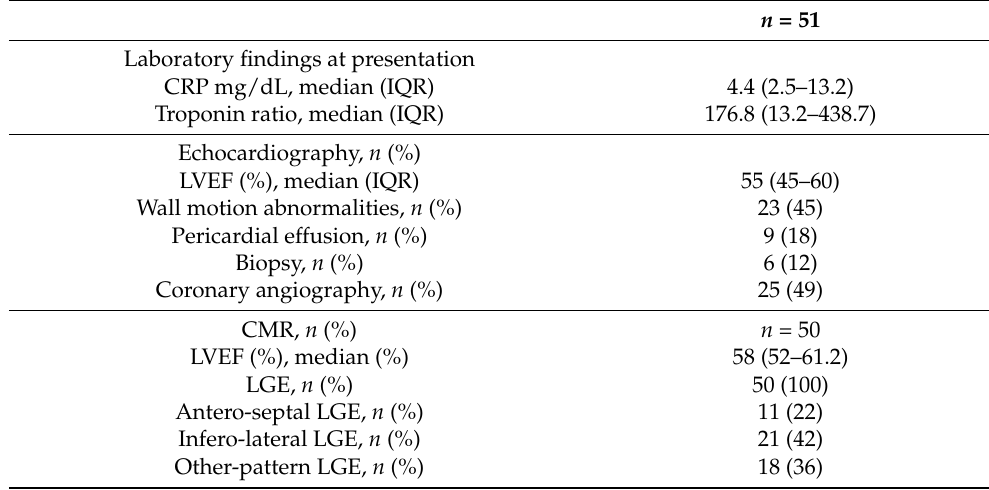
Table 2. Diagnostic findings in patients admitted to ED with AMAM: acute myocarditis; CRP: C reactive protein; LVEF: left ventricular ejection fraction; CMR: cardiac magnetic